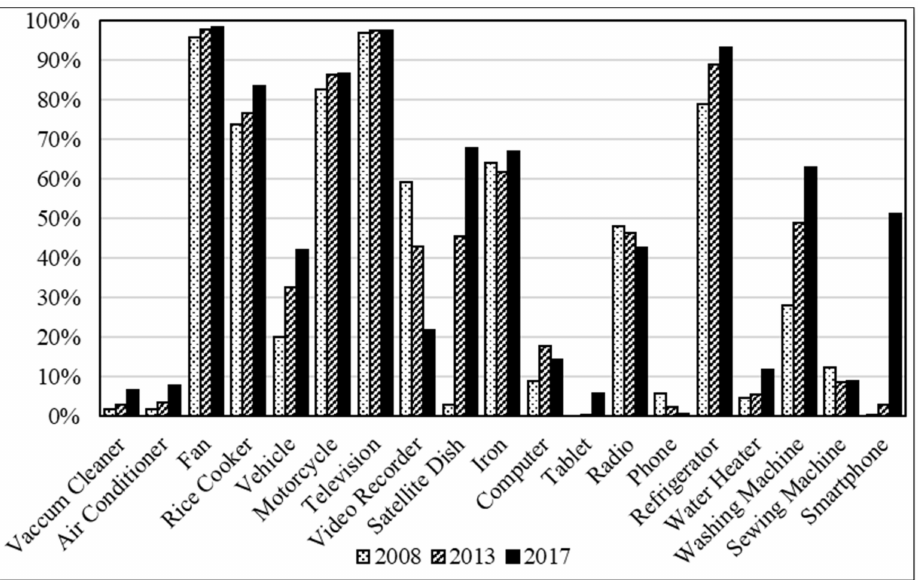
Figure 1. Historic appliance ownership development in Nakhon Phanom based on TVSEP